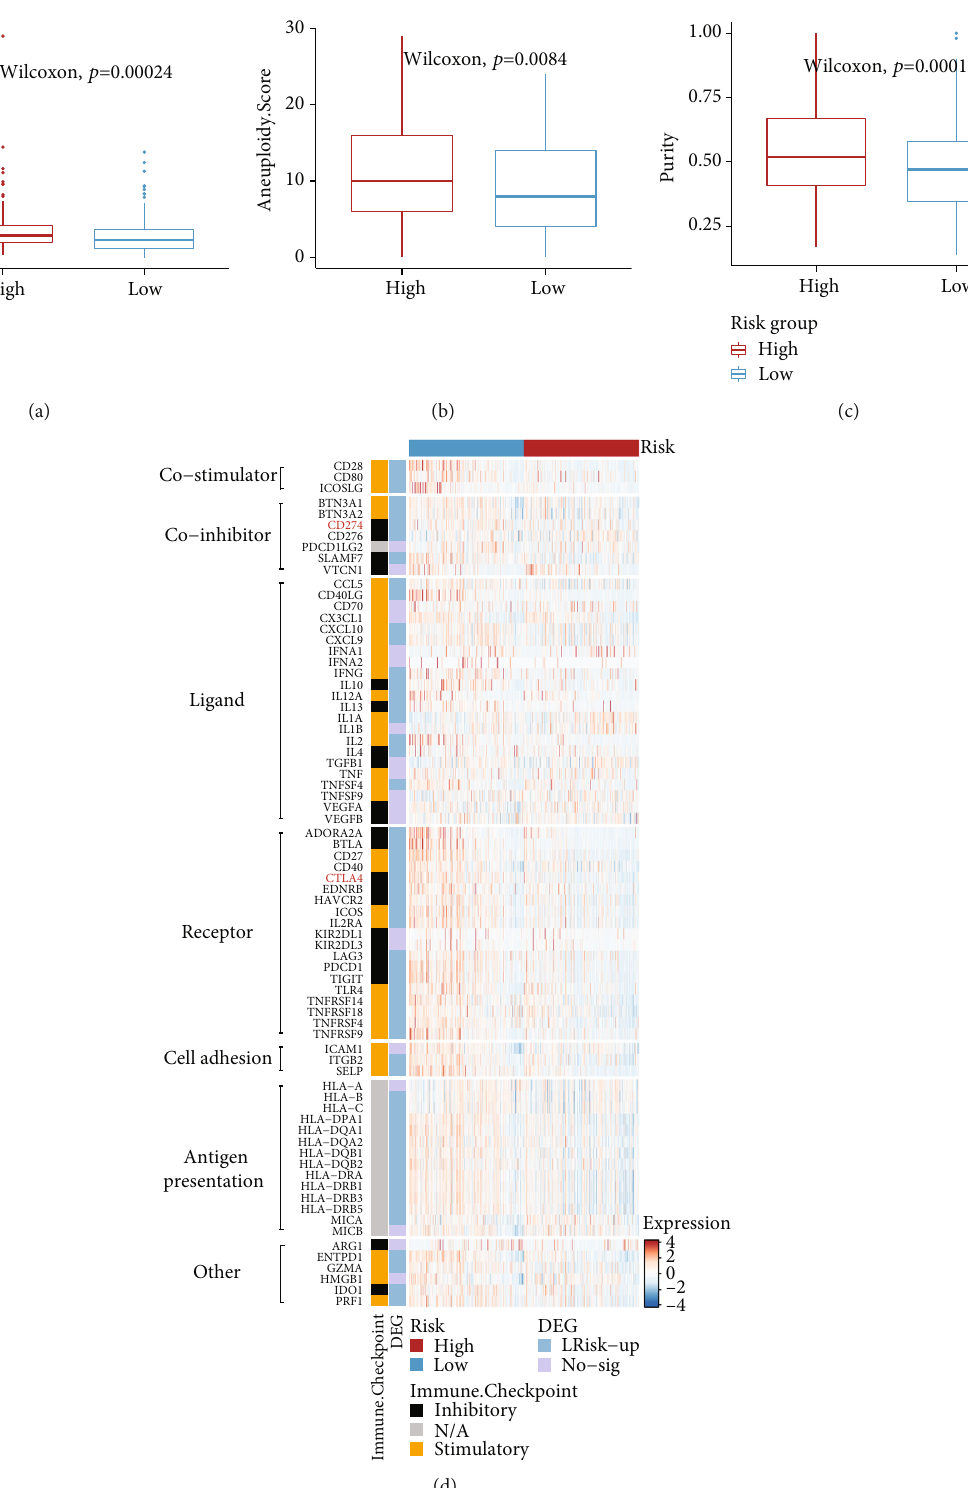
Figure 5: Crossplatform analysis and expression of immune checkpoint genes TCGA cohort. (a – c) Boxplots showed that the low-risk group presented with lower copy number variation (CNV), aneuploidy score, and tumor purity ( p < 0 : 001 ). (d) Heatmap presented with di ff erential expression of immune checkpoint genes in TCGA cohort. Numerous immune checkpoint genes were signi fi cantly higher in the low-risk group ( log 2 − foldchange ð FC Þ > 1 and an adjusted p value < 0.05, “ LRisk-UP ” in the annotation on the right means that the expressions of these genes are upregulated in the low-risk group, and “ No-Sig ” means that there is no statistical di ff erence between these two